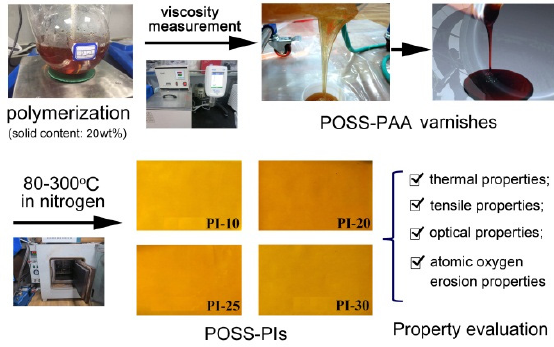
Figure 4. Preparation procedure of PI films.